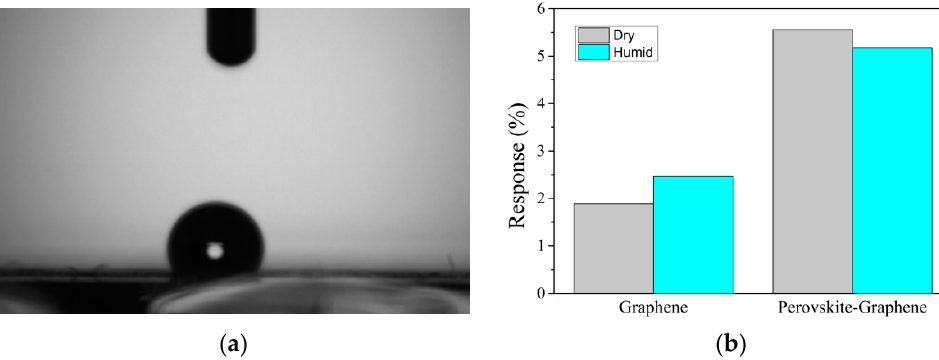
Figure 8. ( a ) Contact angle measurement for graphene loaded with MAPbBr 3 perovskite nanocrystals. Adapted from Sensors MDPI. ( b ) Comparison of the sensing responses for 500 ppm of NO 2 in dry and humid conditions. Reproduced from Sensors MDPI 2019, 19 (20), 4563 .